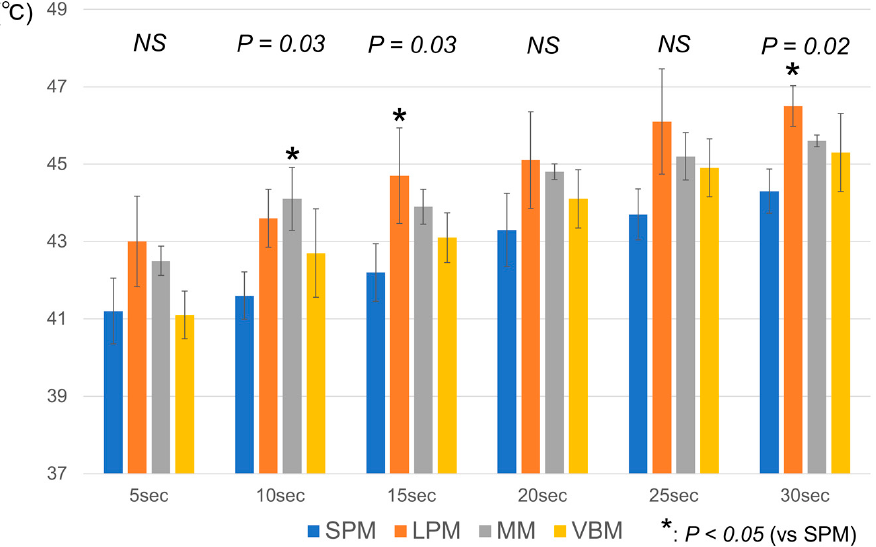
Figure 2. Maximum irrigation temperatures of different laser pulse modes. SPM: short pulse mode; LPM: long pulse mode; MM: Moses mode; VBM: virtual basket mode; NS: not significant.